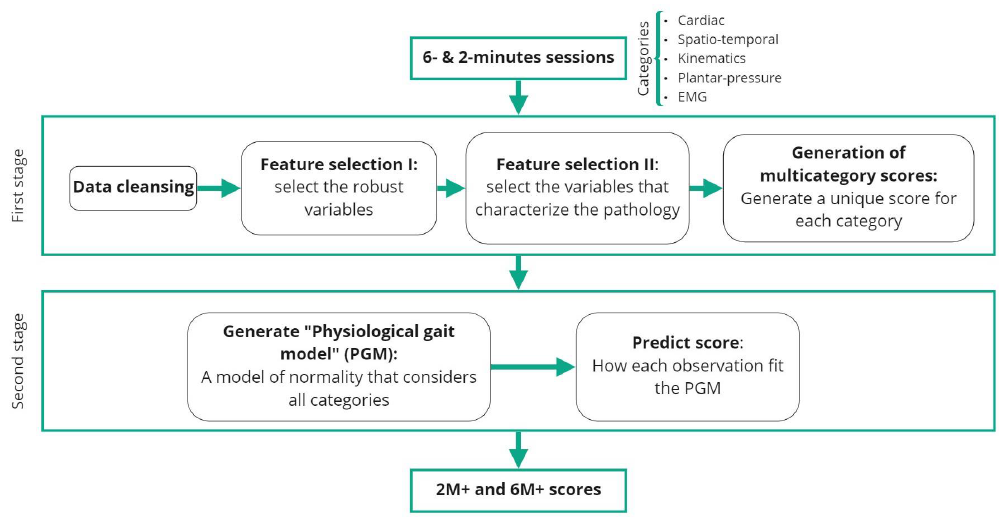
Figure 3. Pipeline for obtaining the global score.